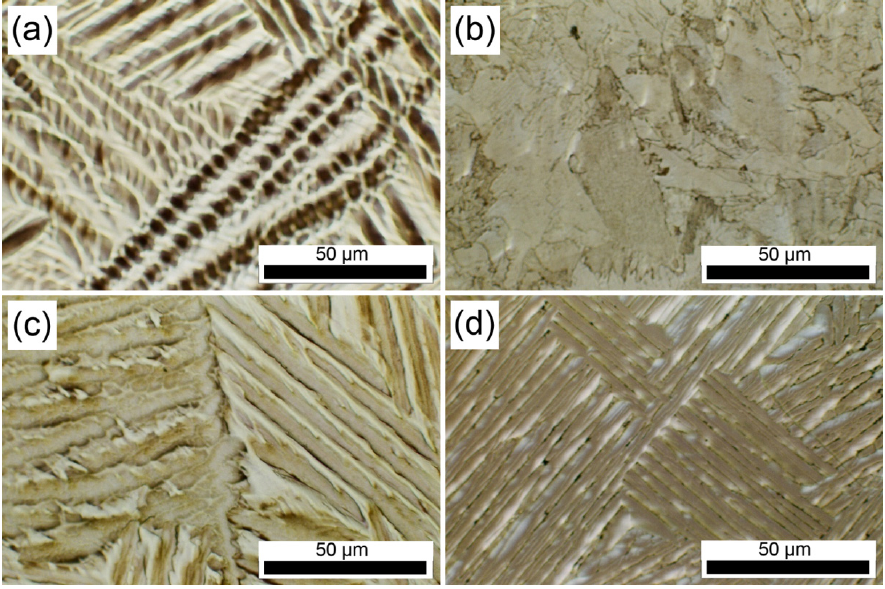
Figure 3. Optical micrographs of Ti– x Ag alloys; ( a ) Ti–5Ag; ( b ) Ti–10Ag; ( c ) Ti–15Ag; and ( d ) Ti–20Ag.